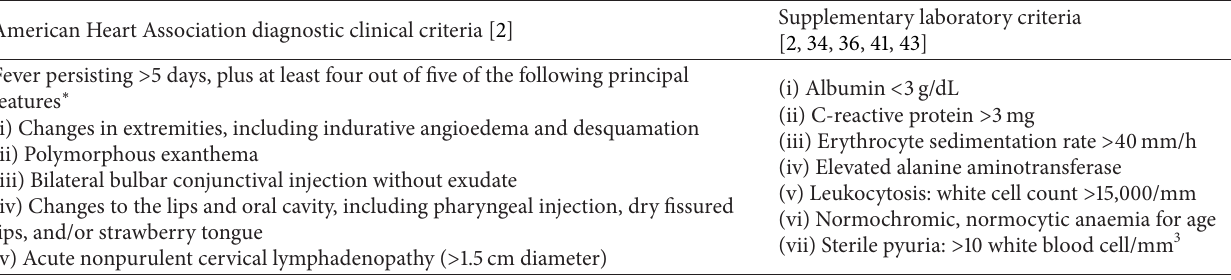
Table 1: Clinical diagnosis criteria as determined by the American Heart Association and laboratory criteria that may be used to help establish the